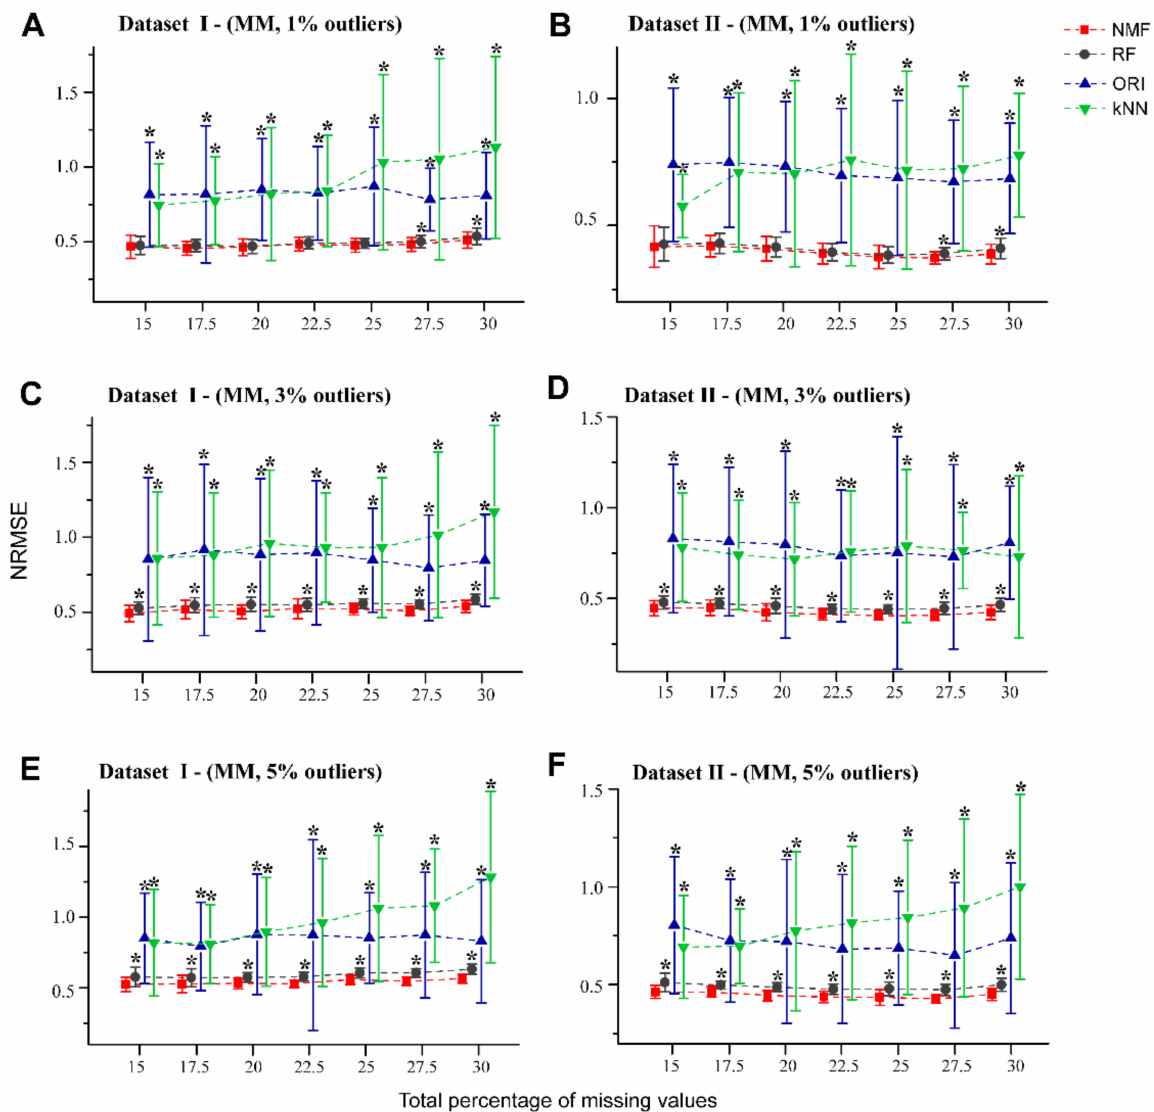
Figure 3. NRMSE curves for NMF, RF, kNN, and ORI apply to the MM type of missing values with 1%, 3%, and 5% outliers. Fifty missingness datasets were generated randomly from the Dataset I ( A , C , E ), and Dataset II ( B , D , F ). Error bars represent the standard deviation with * denoting p < 0.05 ( t -test with BH adjusted) relative to